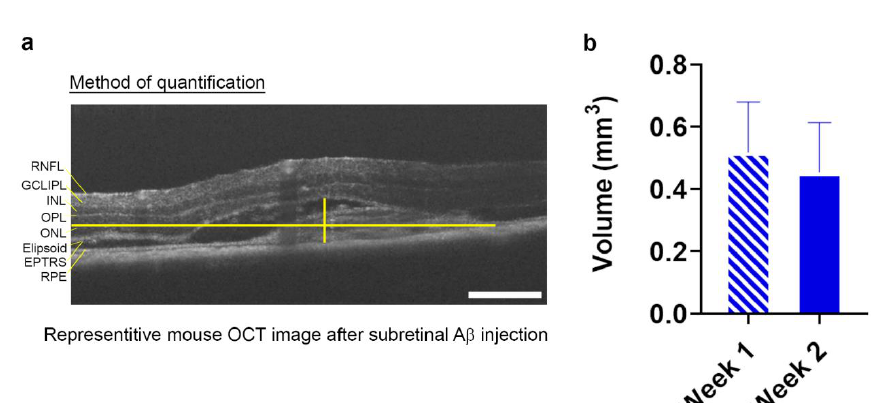
Figure 2. Quantification of Aβ-induced GA-like lesions in living mouse retinae. Optical coherence tomography (OCT) scans of mice subretinally injected with 625 nM human oligomeric Aβ 1-42 revealed the presence of a discernable focal lesion. ( a ) The maximal height and width of the lesion was measured using the caliper tool function as shown in the sample OCT image and ( b ) presented as volumetric measurements at 1 and 2 week post-injection. The average lesion volume measured 0.52 mm 3 ± 0.12 SEM at 1 week and 0.45 mm 3 ± 0.16 SEM at 2 weeks. n = 7 mice ( p = 0.78) Two-tailed Student’s t-test. No significant differences in lesion sizes were observed between weeks 1 and 2. Animals were culled at predetermined end points and the eyes were processed for histological and confocal immunofluorescence studies. Hematoxylin and eosin staining revealed a pattern of localized retinal pathology consistent with OCT findings. We ob- served disrupted/atrophic RPE, the absence of photoreceptor outer segments (OS) and disorganized inner segments (IS) (Figure 3b). Discrete cystic spaces were also evident where tissues had parted, likely corresponding to areas of fluid accumulation and hypo- reflective spaces observed during OCT imaging. However, damage was confined to the outer retina, whilst the inner retina appeared to be largely unaffected. There was no evi- dence of ocular pathology in vehicle-injected animals in weeks following the experiment (Figure 3a). Confocal immunofluorescence studies in which cryo-sectioned Aβ-treated eyes were probed with β3-tubulin and rhodopsin provided further evidence of damage, where widespread disruption was observed at localized areas of the retina–RPE interface (Figures 3d and S3). By contrast, photoreceptor and RPE layers appeared normal in vehi- cle-treated eyes (Figures 3c and S3). As pathology was confined to the outer retina, we quantified this in blinded histological sections, whereby regions of interest were scored for damage at 200 μm intervals on an arbitrary scale. Findings are reported as average percentage abnormalities for IS: 4.0 ± 2.1 SEM in Aβ-treated eyes and 2.5 ± 1.7 SEM in vehicle controls (Figure 3e). OS: 28.0 ± 3.7 SEM in Aβ-treated eyes and 19.1 ± 5.2 SEM in vehicle controls (Figure 3f). RPE/Choroid: 30.7 ± 3.3 SEM in Aβ-treated eyes and 14.5 ± 4.1 SEM in vehicle controls (Figure 3g). No significant differences were observed between Aβ- vs. vehicle-injected eyes for IS and OS layers, although a pattern indicating dimin- ished OS was observed after Aβ exposure. By contrast, significant disruption was rec- orded in the RPE/Choroid following Aβ treatment compared to control eyes.